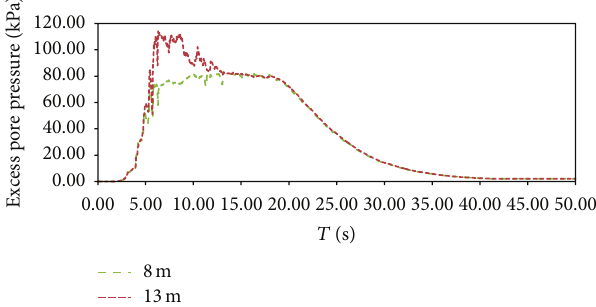
Figure 5: Excess pore pressure at 13.00 m and 8.00 m depth.